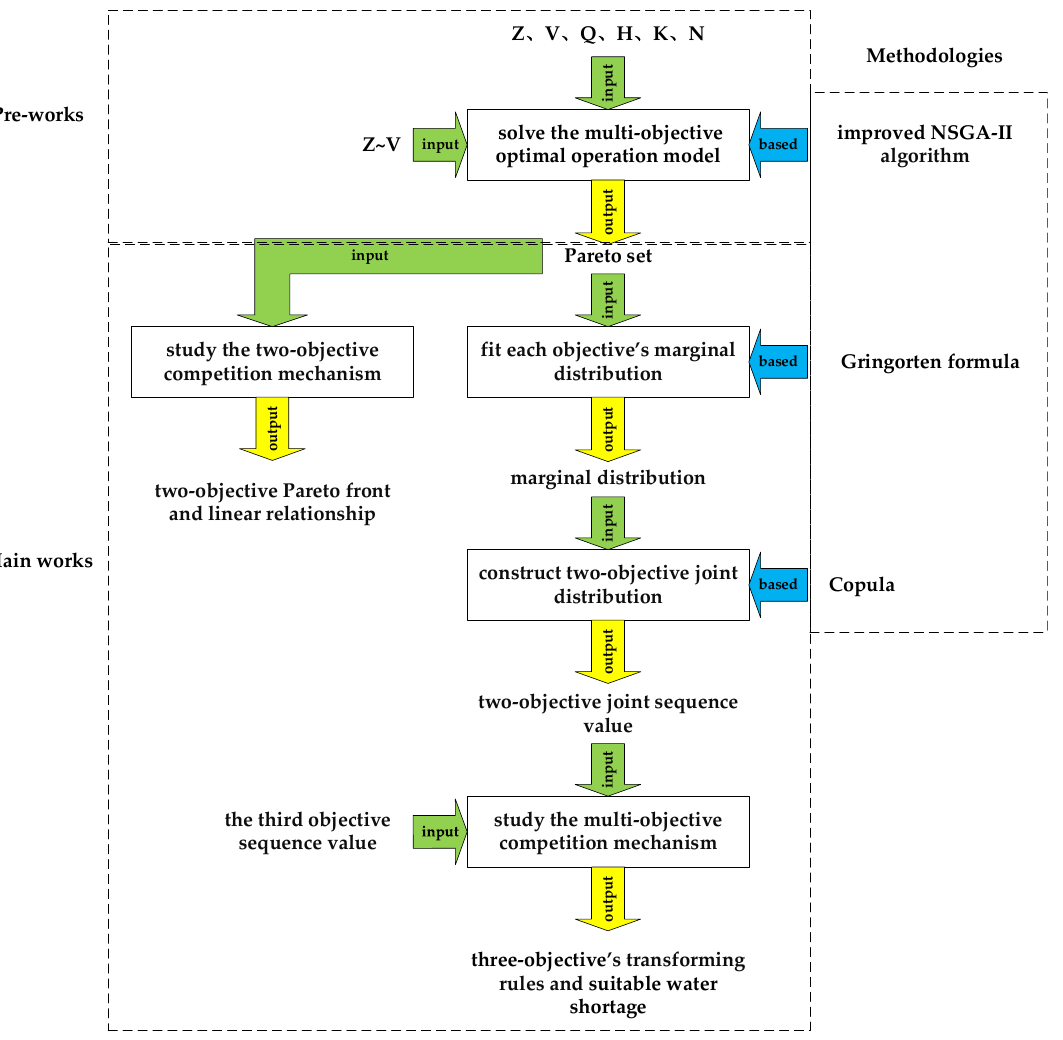
Figure 2. The main research framework.